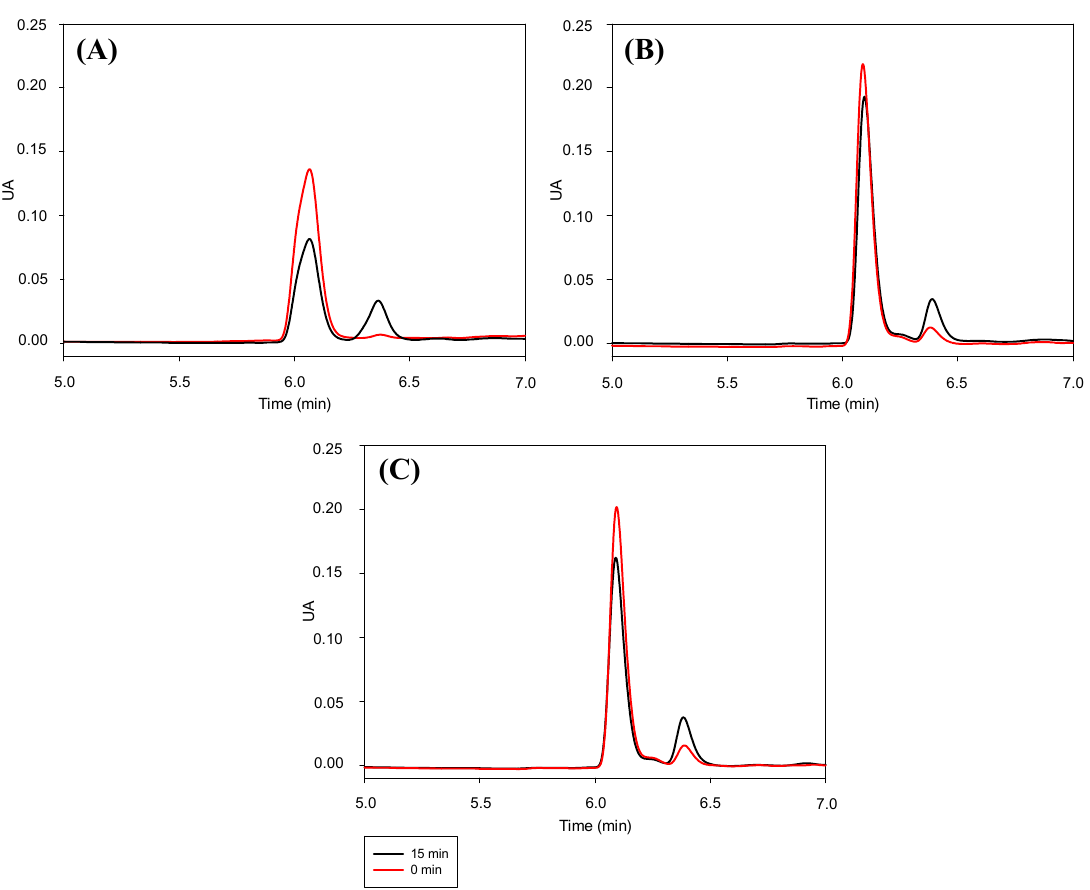
Figure 5. Chromatograms of ( A ) RSV ethanolic solution, ( B ) RSV-Tw80:Sp80 and ( C ) RSV-Tw80:Sp80:Dod niosomes at 0 min (red line) and 15 min (black line) after UV light exposure.